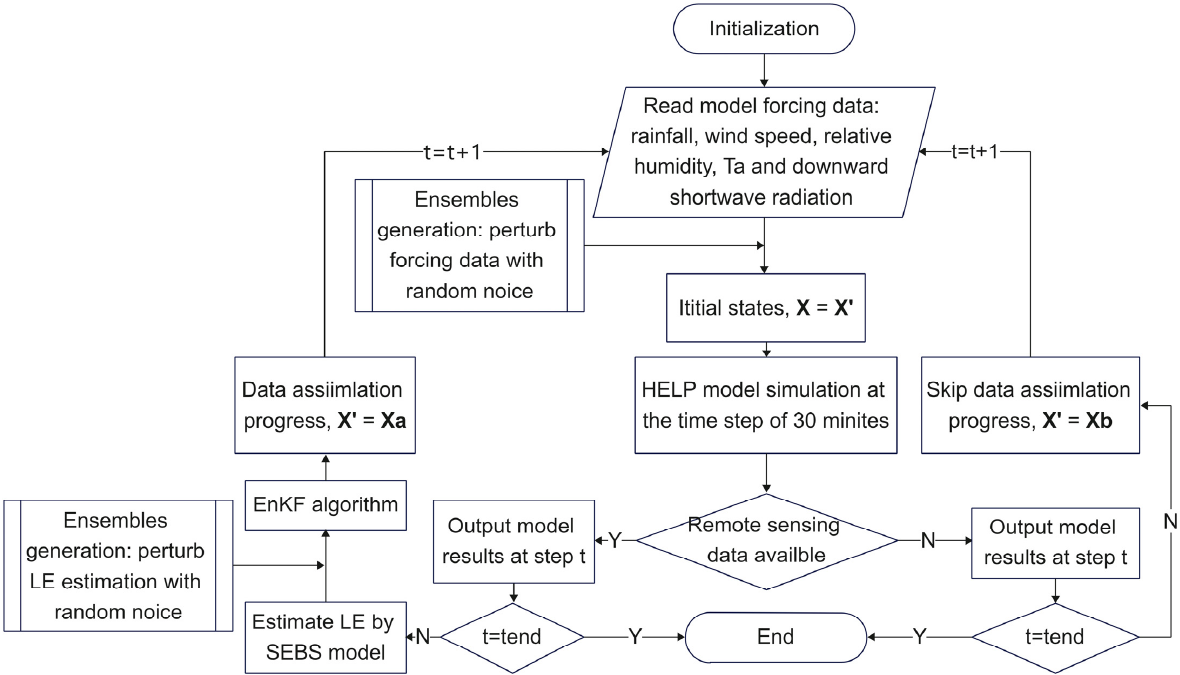
Figure 2. Workflow of this research.